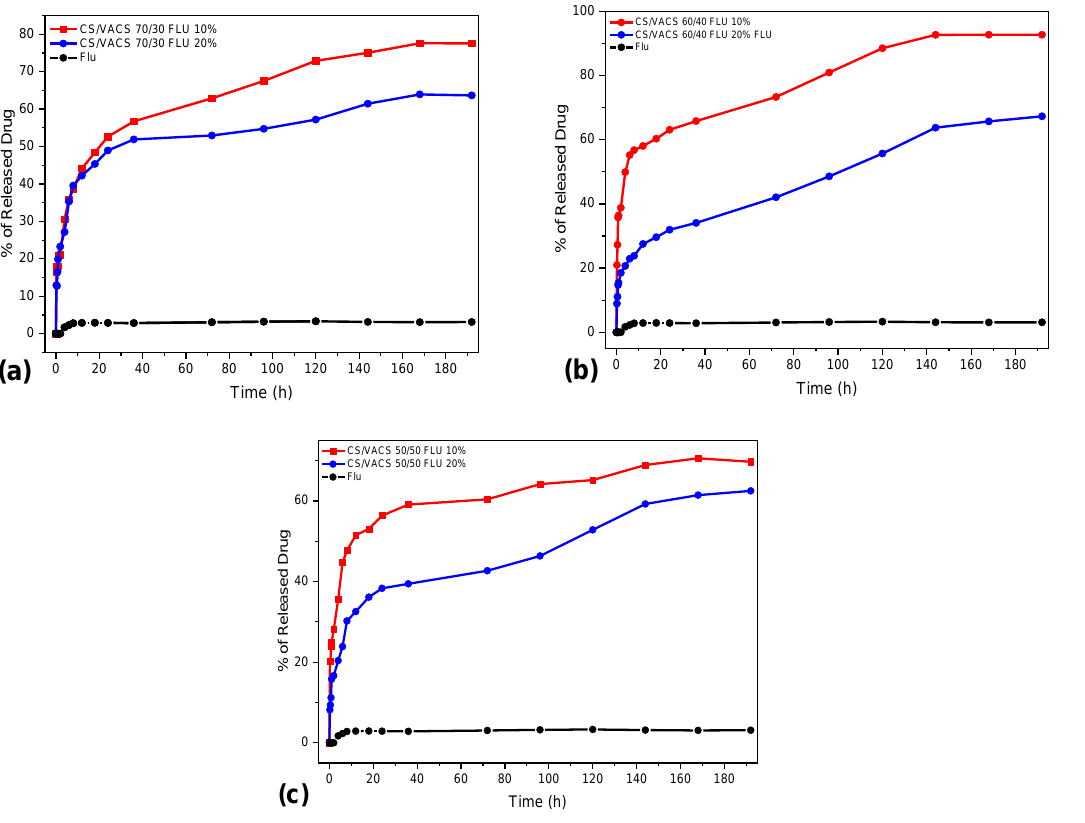
Figure 10. In vitro release of FLU from CS/VACS/iCR patches at pH 7.4. ( a ) CS/VACS 70/30, ( b ) CS/VACS 60/40, ( c ) CS/VACS